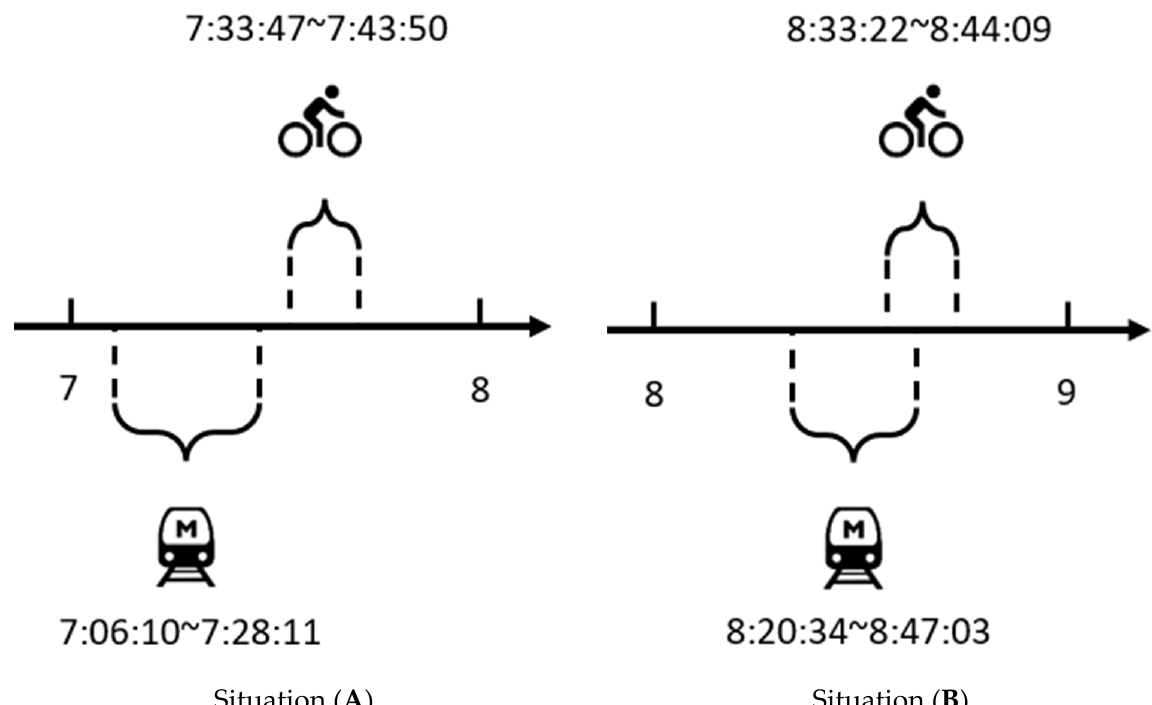
Figure 4. Schematic diagram of temporal conflict.